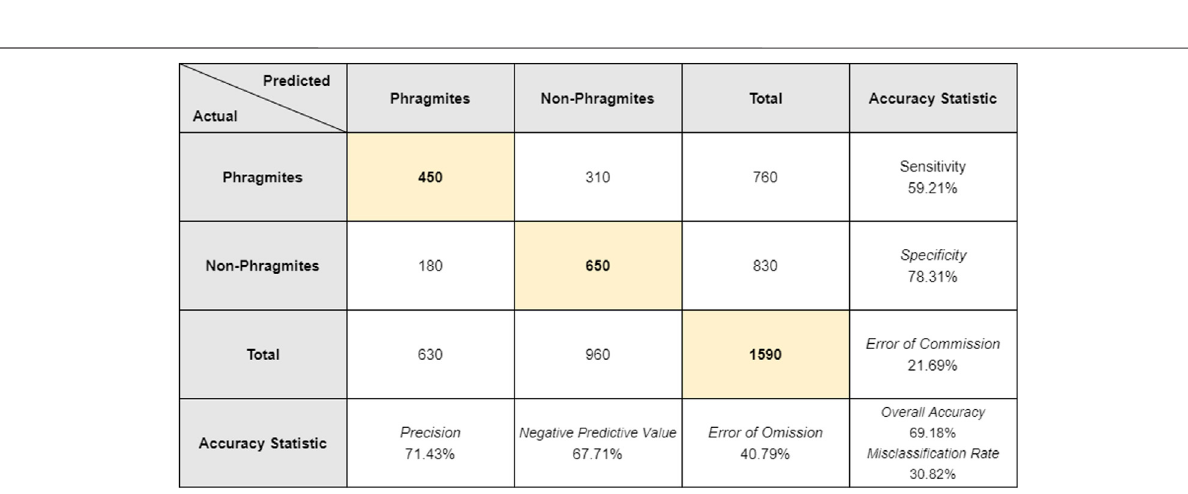
FIGURE 11 | The distribution and range of SAM pixel values for (A) target Phragmites pixels and (B) background pixels.